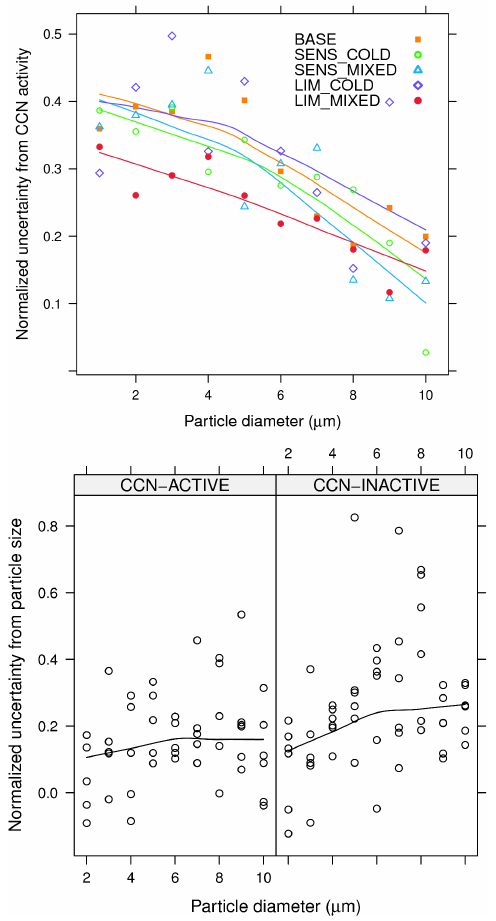
Fig. 8. Top: normalized model uncertainty from CCN activity, as a function of particle diameter. Bottom: normalized model uncer- tainty due to particle size, as a function of particle size. Lines in both panels are local polynomial regression fits to the points, and are provided as a guide to the eye. The color key is indicated in the top panel.